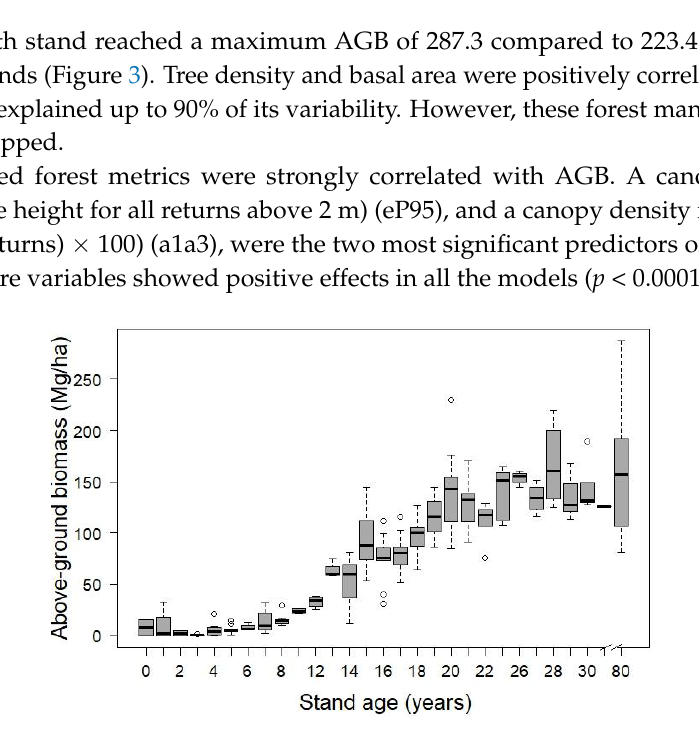
Figure 3. Tree above ground biomass storage (DBH > 5 cm) (including stem, branches, and foliage) in the chronosequence at the managed forest landscape in central Mexico. Circles represent AGB observations at plot level outside 1.5 times the interquartile range above the upper quartile and below the lower quartile of the boxplot.